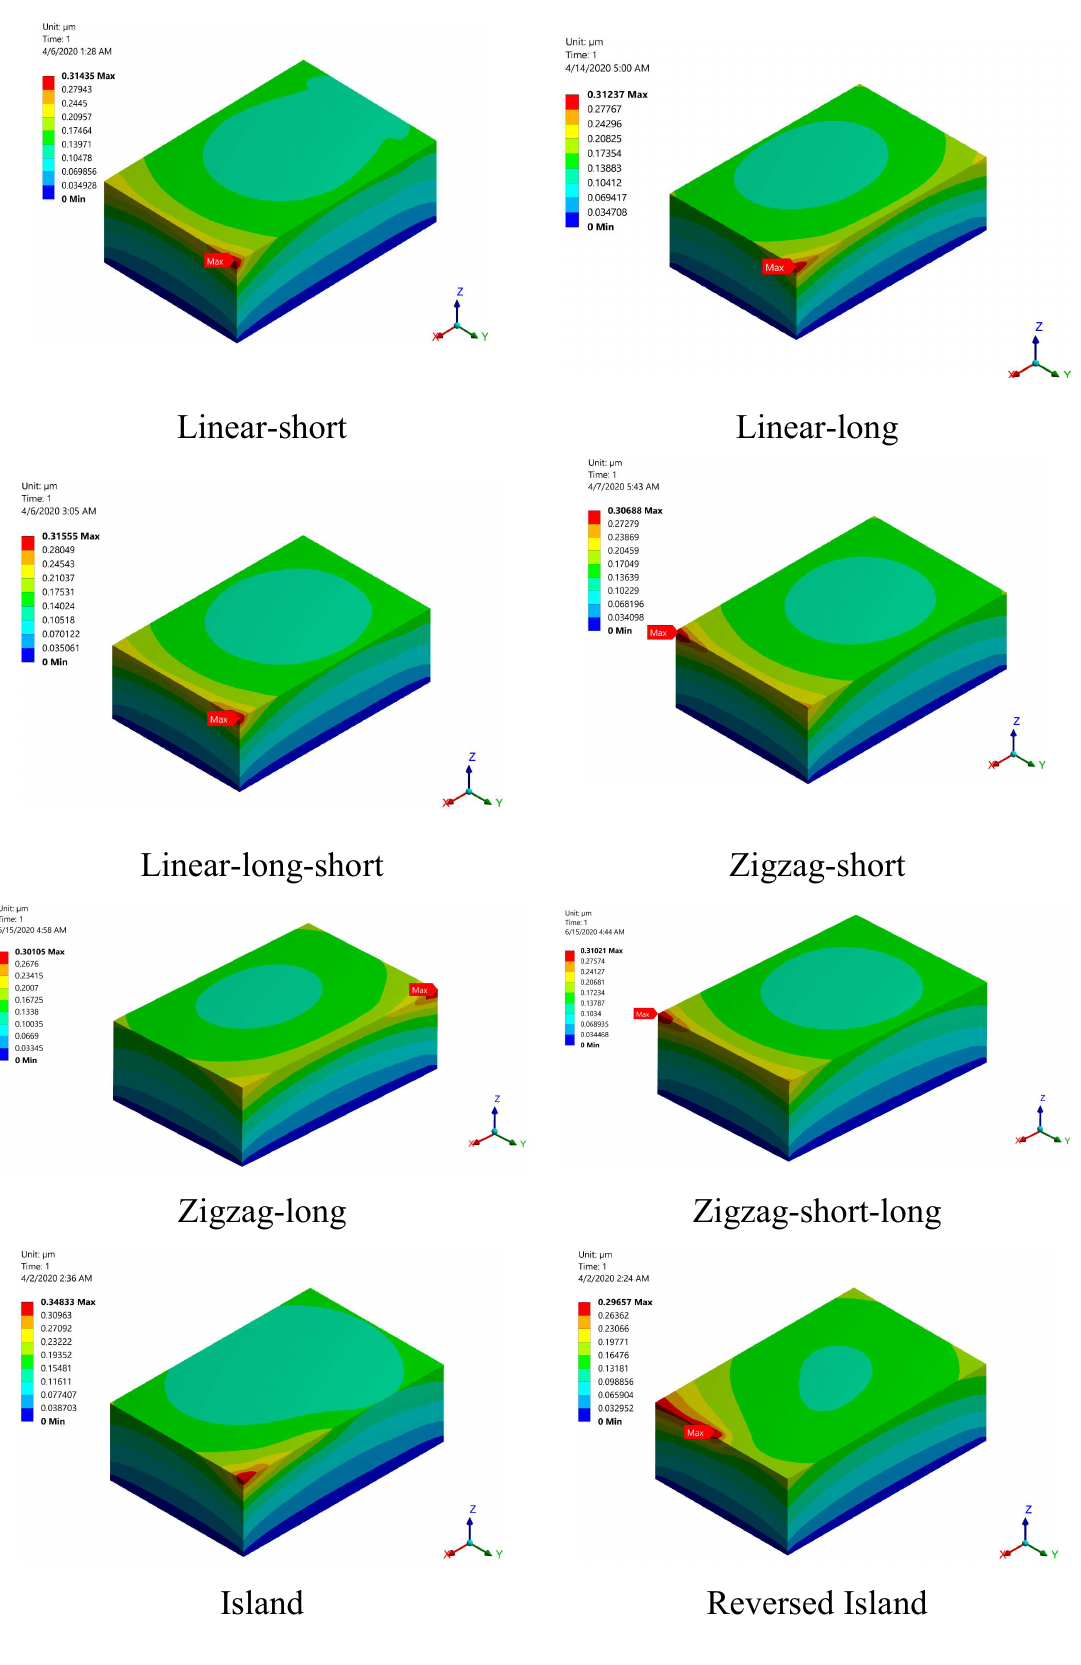
Figure 14. Distortion contours for the studied build ordinations just after solidification. Figure 15 depicts a bar chart for the normalized von Mises stress and distortion for the investigated build orientations. For the linear build orientations, the long-linear orien- tation had the highest residual stress, i.e., 13.3 percent above the yield limit, while the linear-short and linear-long-short orientation had the lowest residual stress, i.e., 12.2 per- cent above the yield limit. All of the linear build orientations produced nearly identical distortion results.